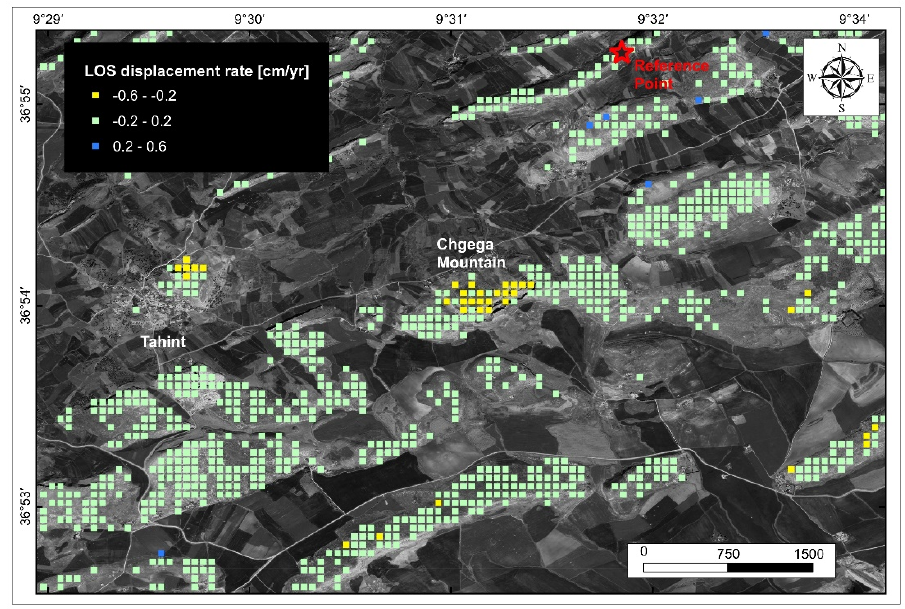
Figure 13. LOS velocity map of the region of the Chgega Mountain using DINSAR. Note the move- ment detected in the Chgega landslide and in the northern slope of the hill adjacent to Tahint village.